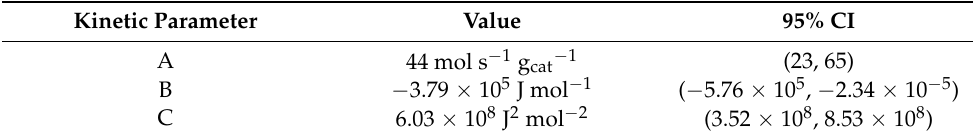
Table 2. Kinetic parameters for sub-Arrhenius behavior.